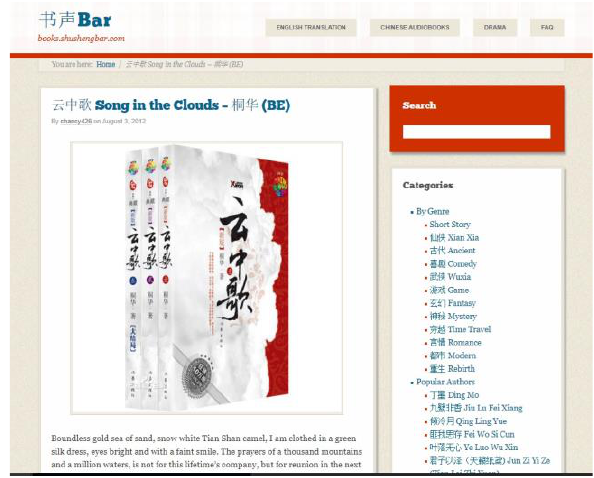
Figure 1 – The Song in the Clouds/Yun Zhong Ge page in Shusheng Bar. Figure 2 - List of English translations of